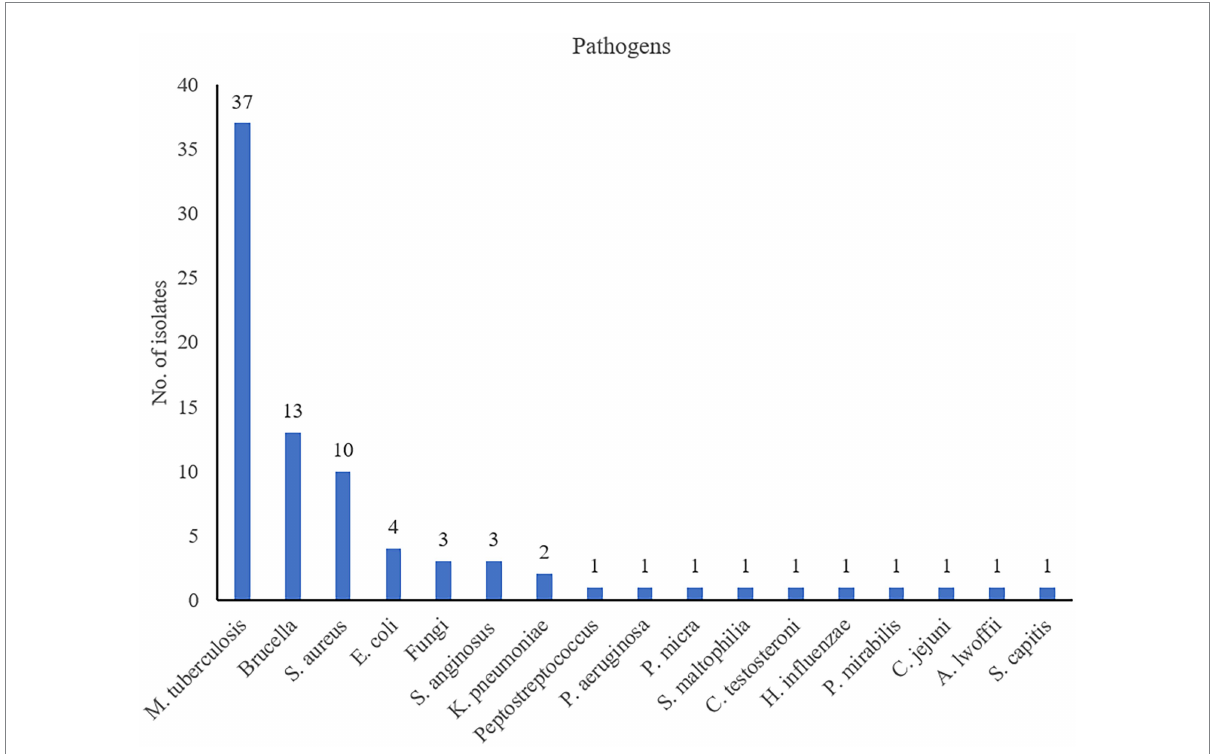
FIGURE 1 Composition of pathogens detected in 82 patients with spinal infection.